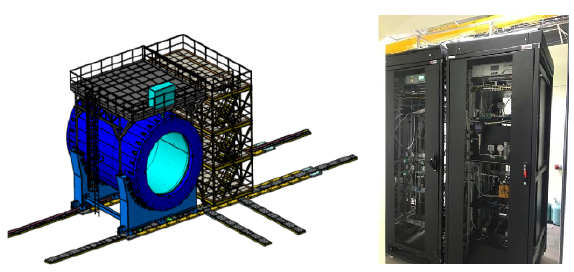
Figure 1. Left: MPD detectors and platform for MPD electronics and Slow Control System [2]. Right: RACK for Gas Supply